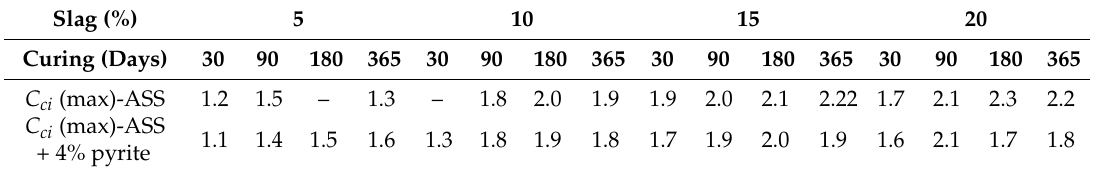
Table 4. Maximum instantaneous slope ( C ci ) of e-log σ 1 plot for alkali-activated slag treated ASS. Slag (%) 5